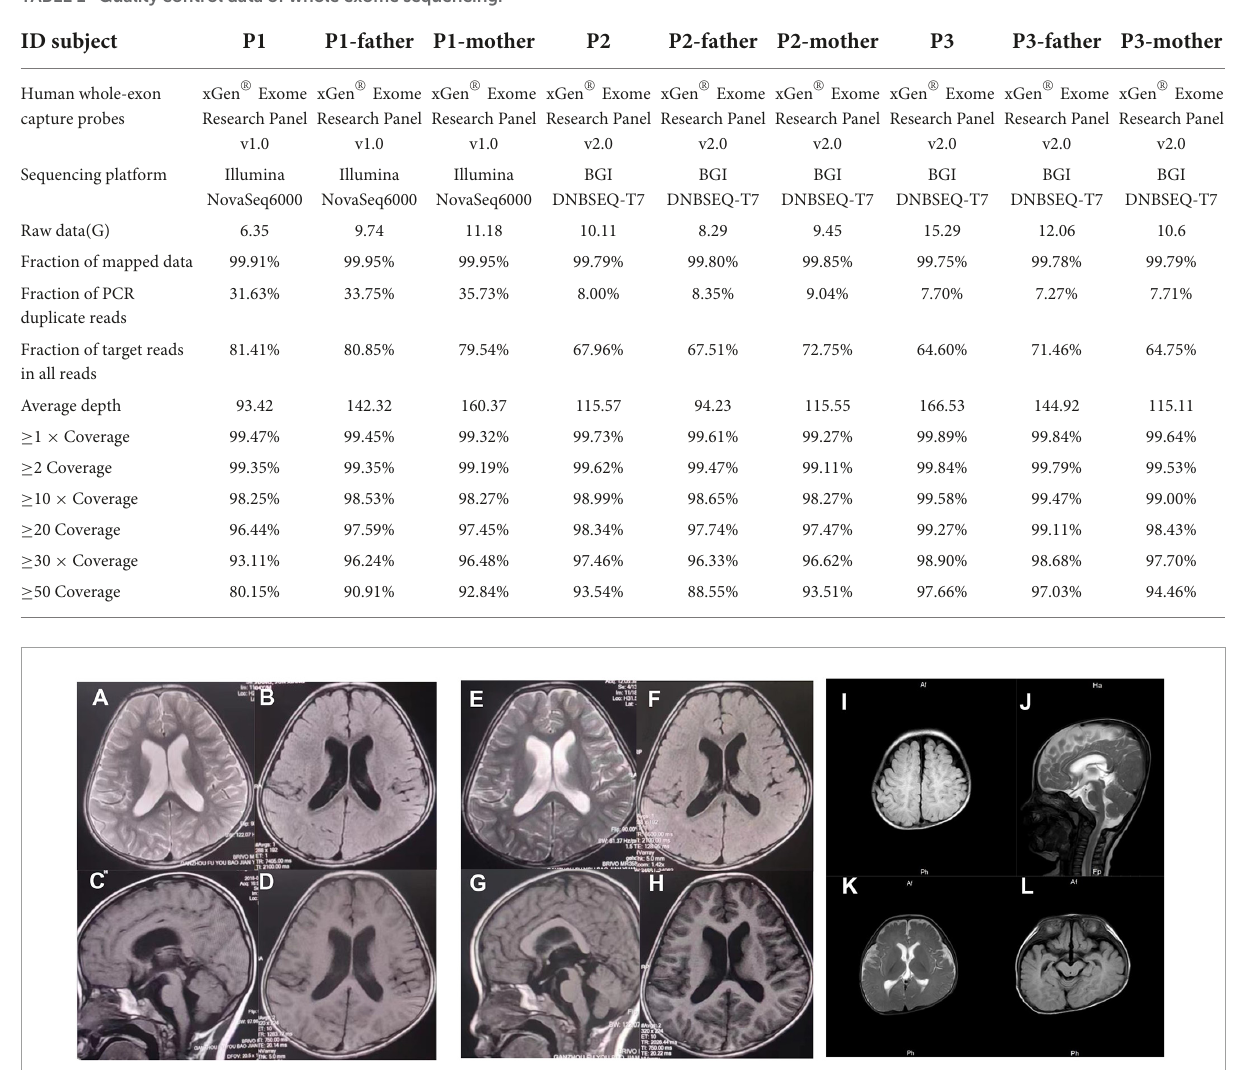
FIGURE2 At the age of 4 years, 6 months (A–D) , and 5 years 1 month (E–H) , brain MRI (3T) of patient 1 showed lateral ventricles dilation, dilation of Virchow-Robin spaces, and dilated the third ventricle. (I–L) Brain MRI (3T) of patient 3 revealed delayed myelination and a widened subarachnoid